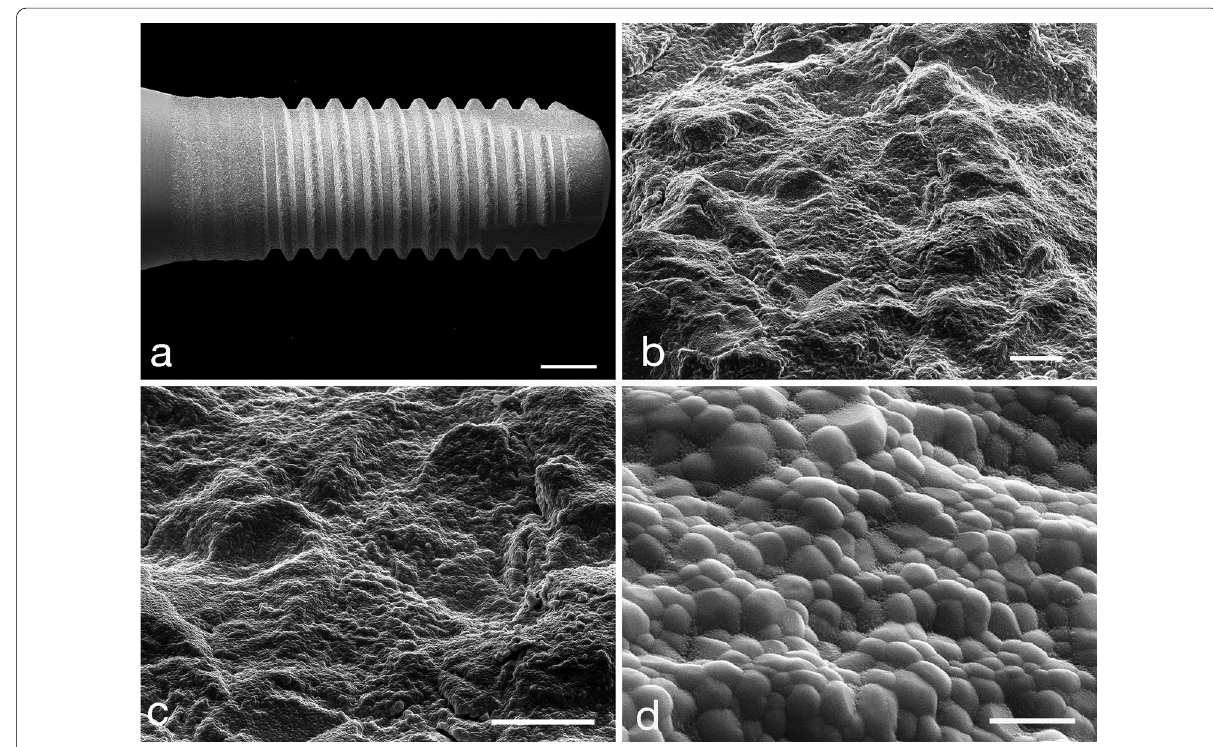
Fig. 1 SEM micrographs of an YTZP implant. a Magnification: magnification: